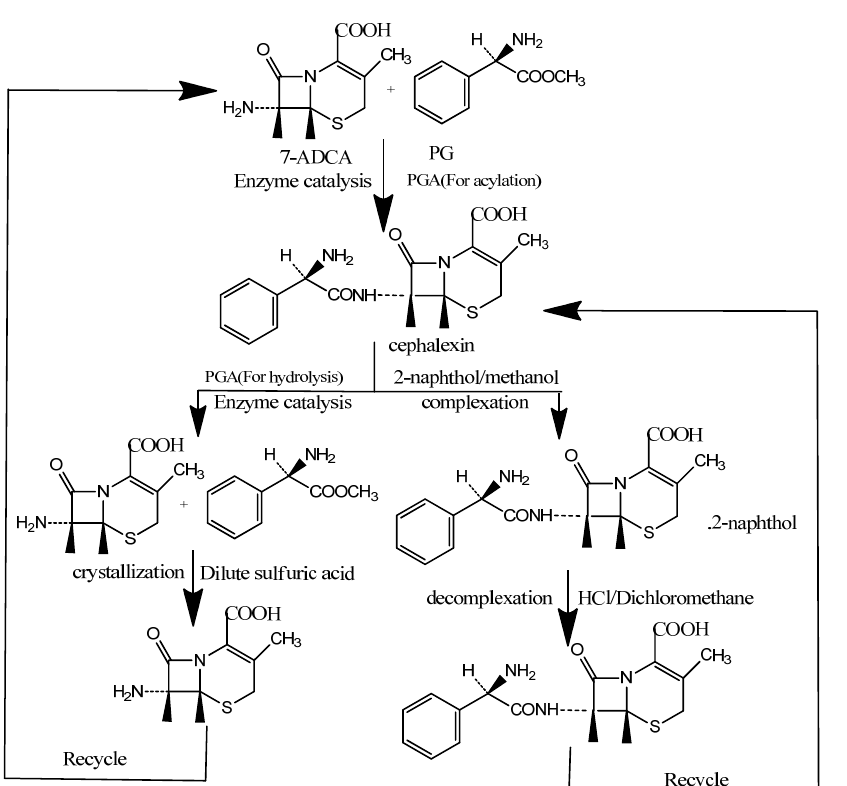
Figure2. Preparation process of cephalexin (enzymatic catalysis method and complex method). Figure 2. Preparation process of cephalexin (enzymatic catalysis method and complex